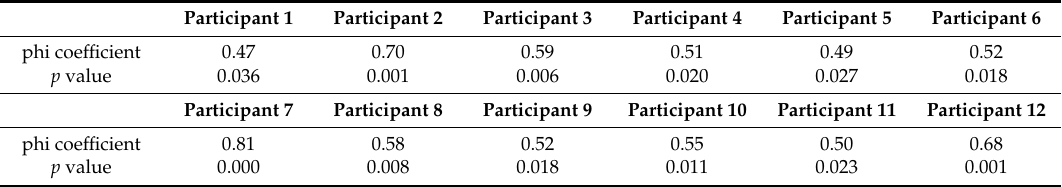
Table 7. Correlation of spontaneous facial a ff ect and a ff ect state translated by participants’ brain signals triggered by video